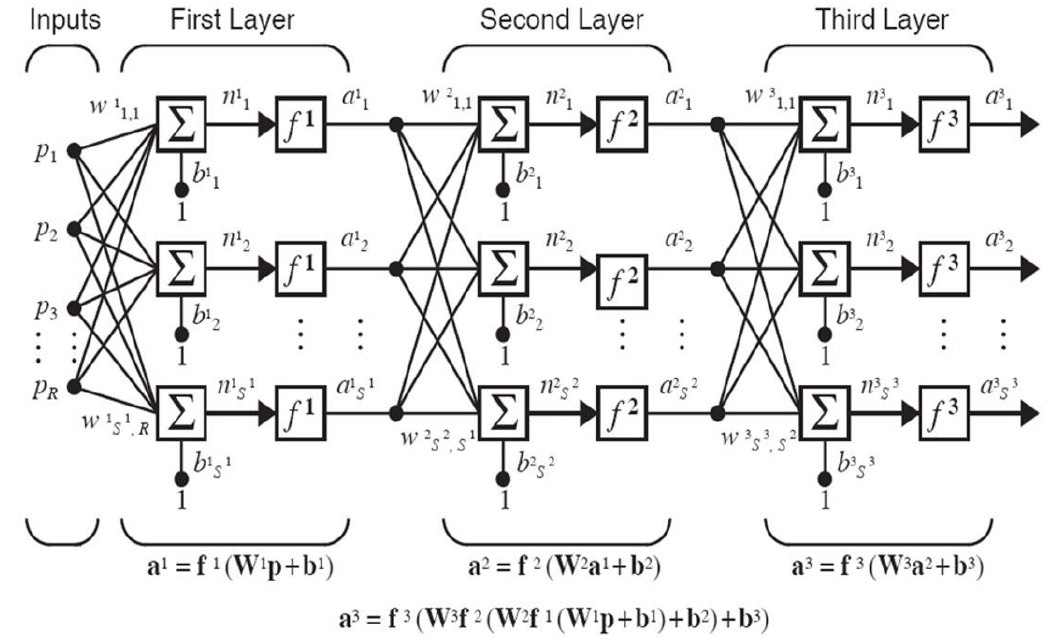
Figure 1: The structure of a multilayer ANN